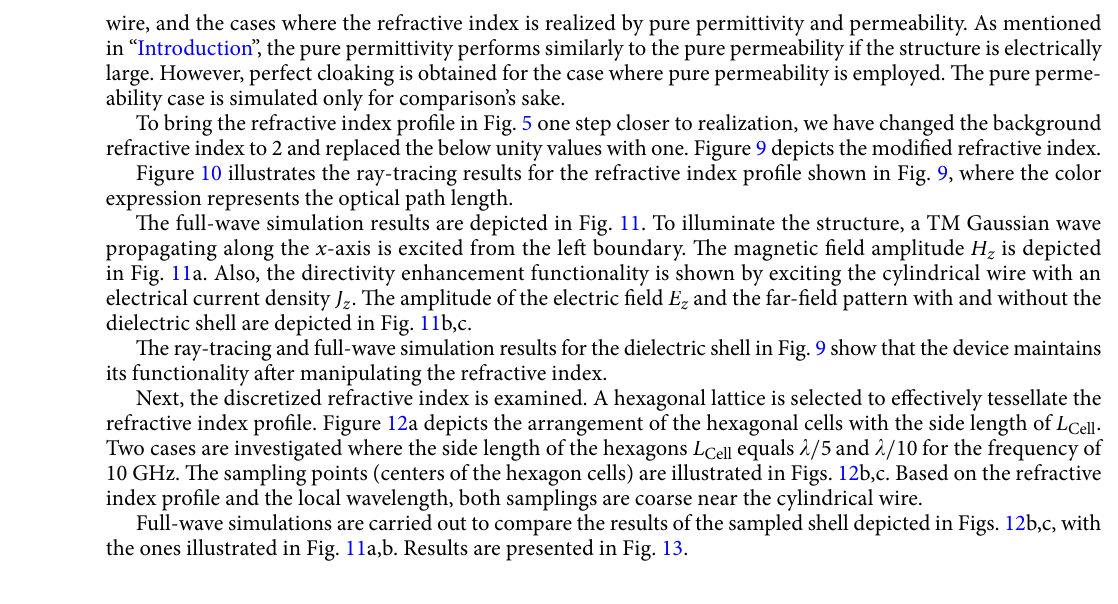
Figure 8. The amplitude of H z for a TM Gaussian wave illuminating the wire antenna covered with ( a ) no cloak, ( b ) a pure dielectric cloak, and ( c ) a pure magnetic